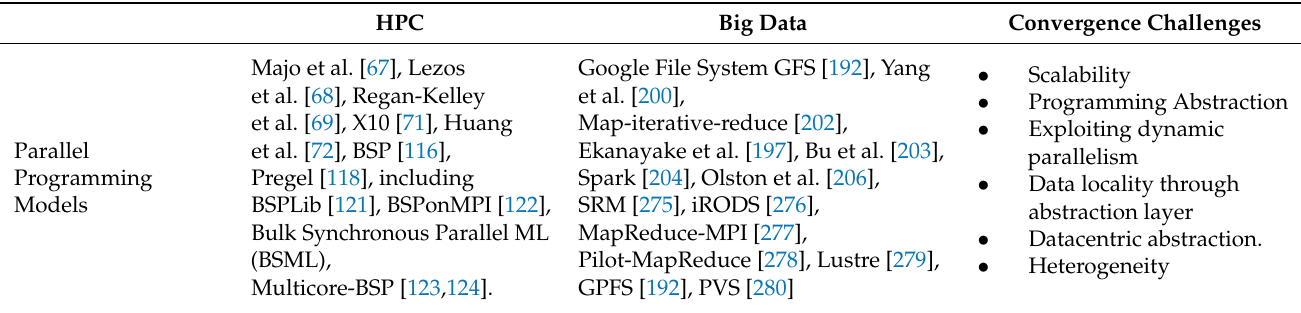
Table 1. Data Locality-aware research efforts in HPC & Big data Environment and Convergence